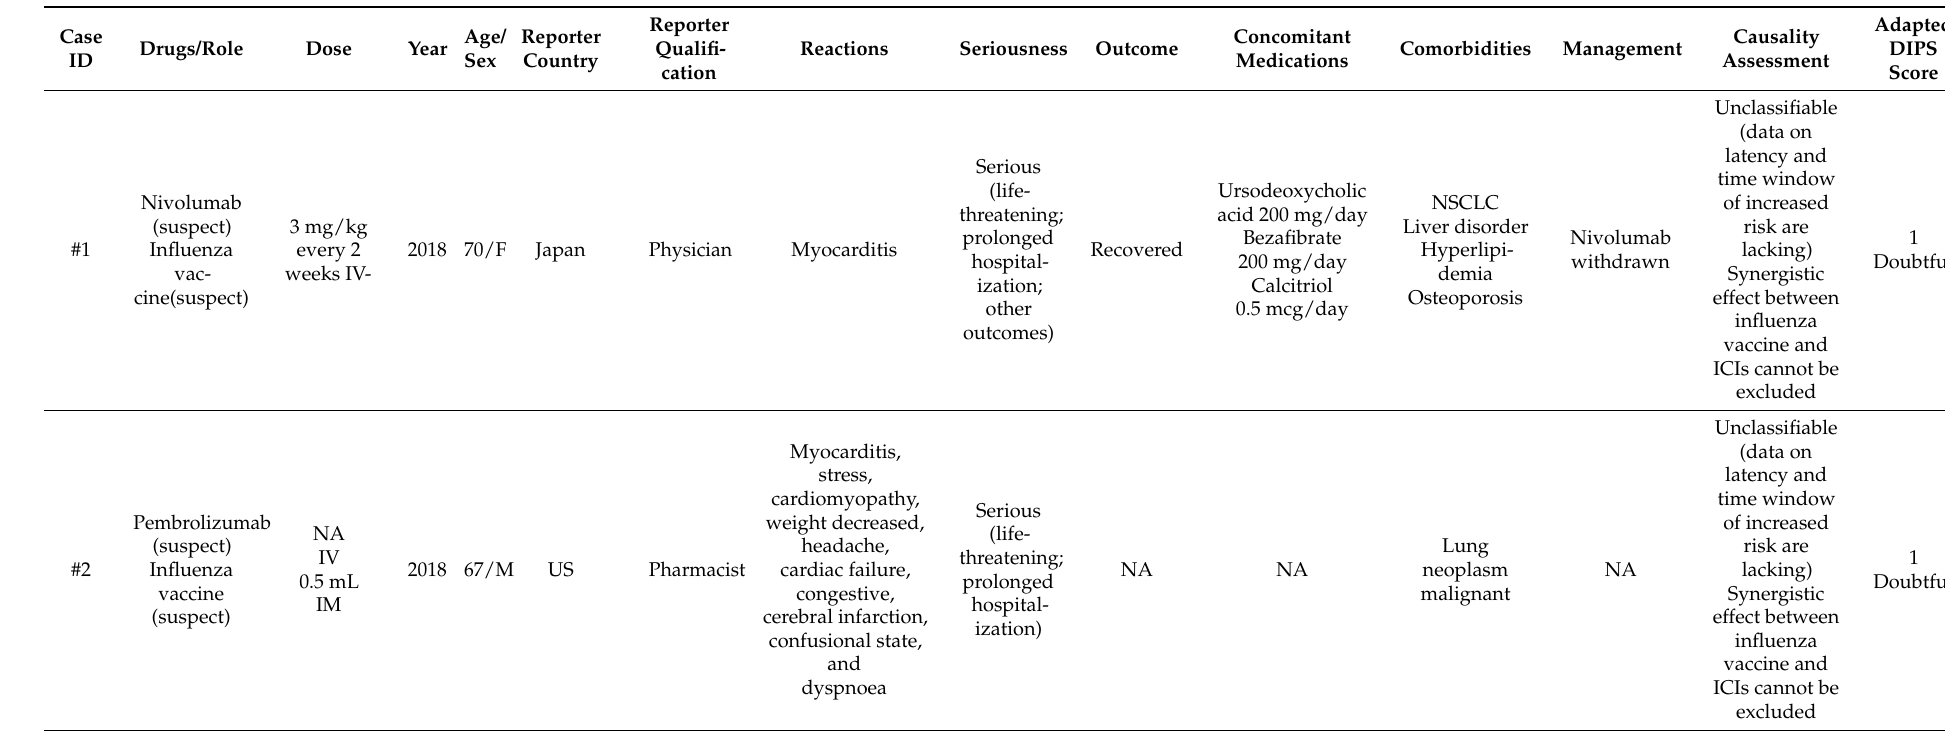
Table 2. Case-by-case assessment of reports concerning myocarditis or pericarditis in which the influenza vaccine and immune checkpoint inhibitors (ICIs) were concomitantly